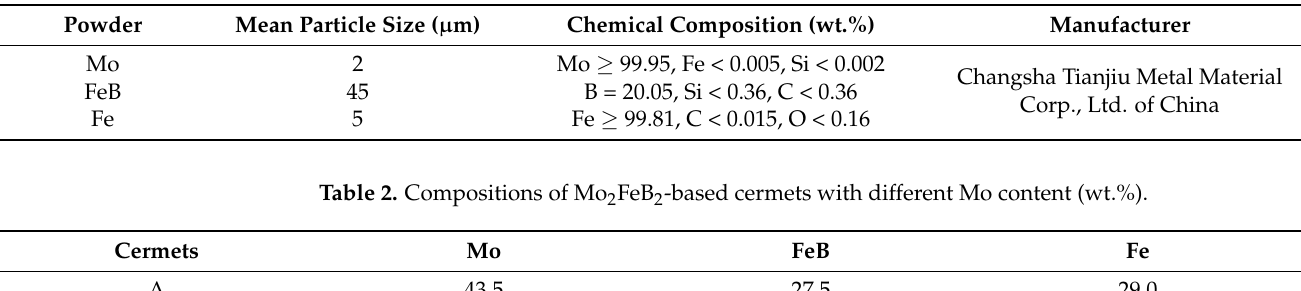
Table 1. Characteristics of raw powders [23].